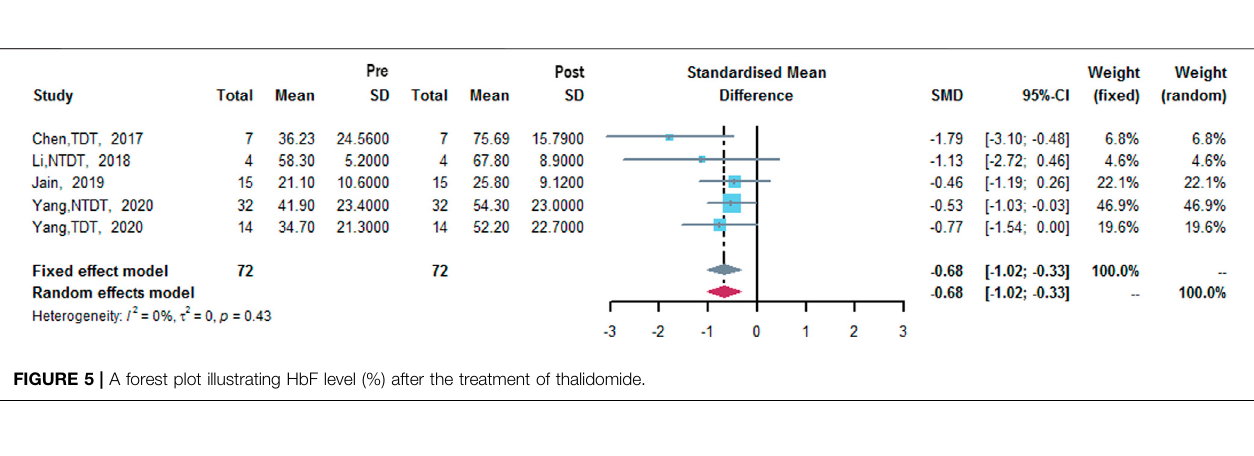
FIGURE 4 | A forest plot illustrating Hb level (g/dl) after the treatment of thalidomide in population-based subgroups.